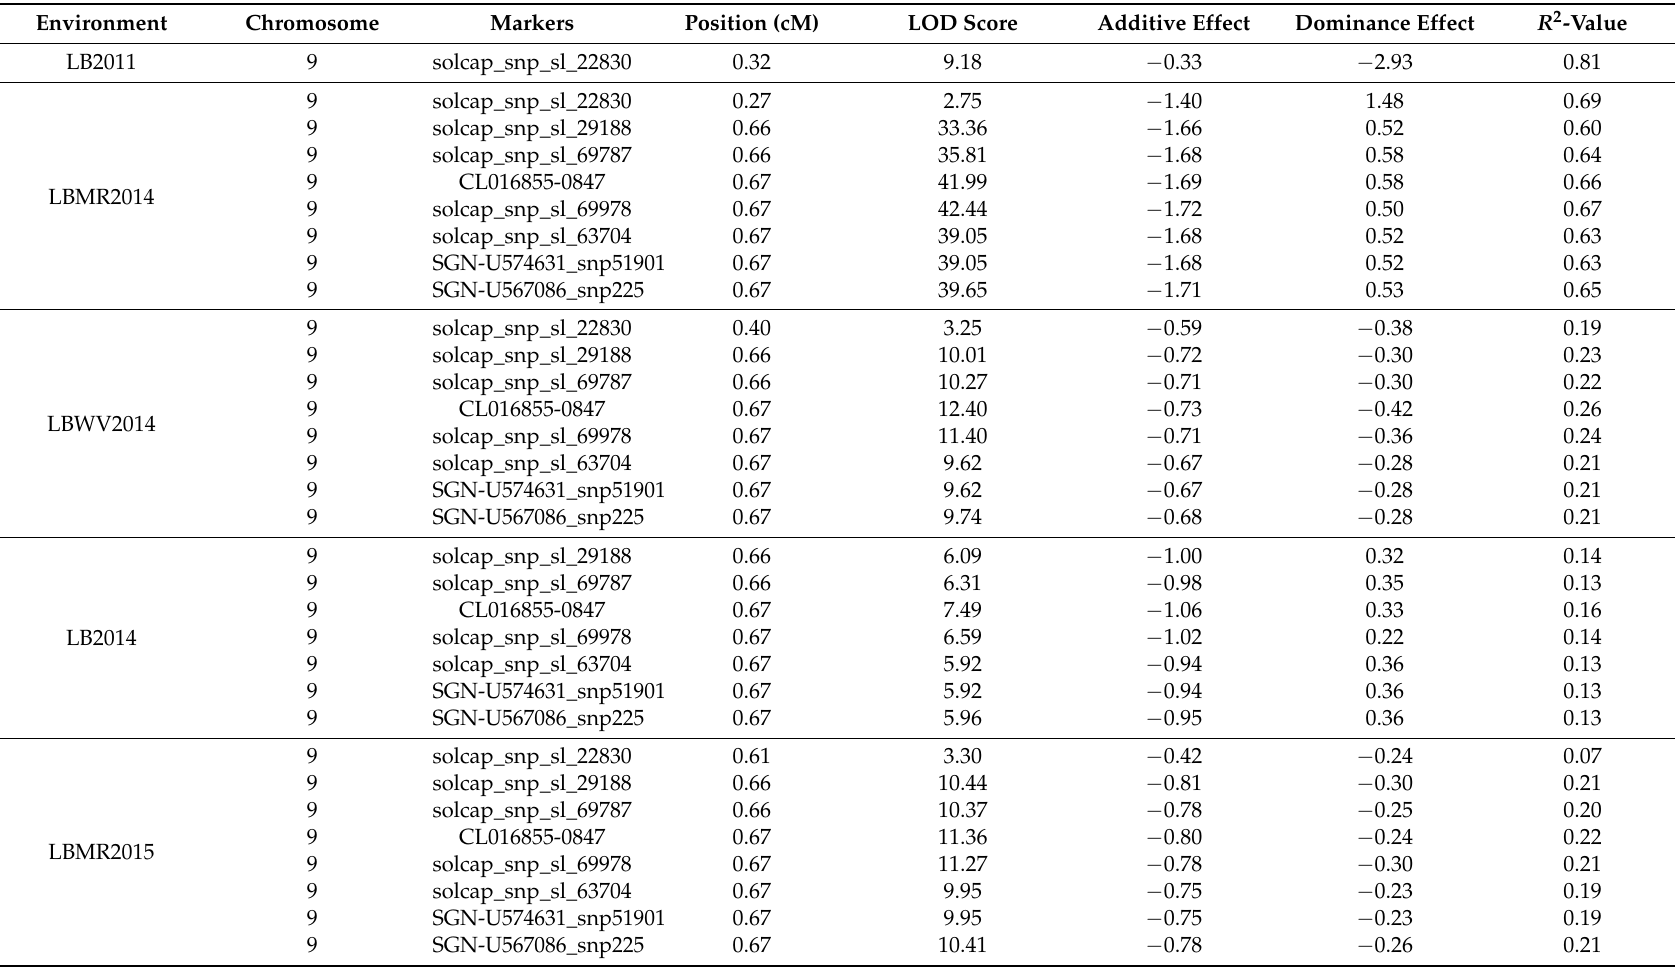
Table 3. Molecular markers on different chromosomes with likelihood of odd (LOD) scores associated with Late blight.